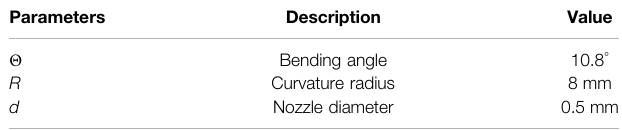
TABLE 4 | Optimum nozzle structure parameter values Parameters